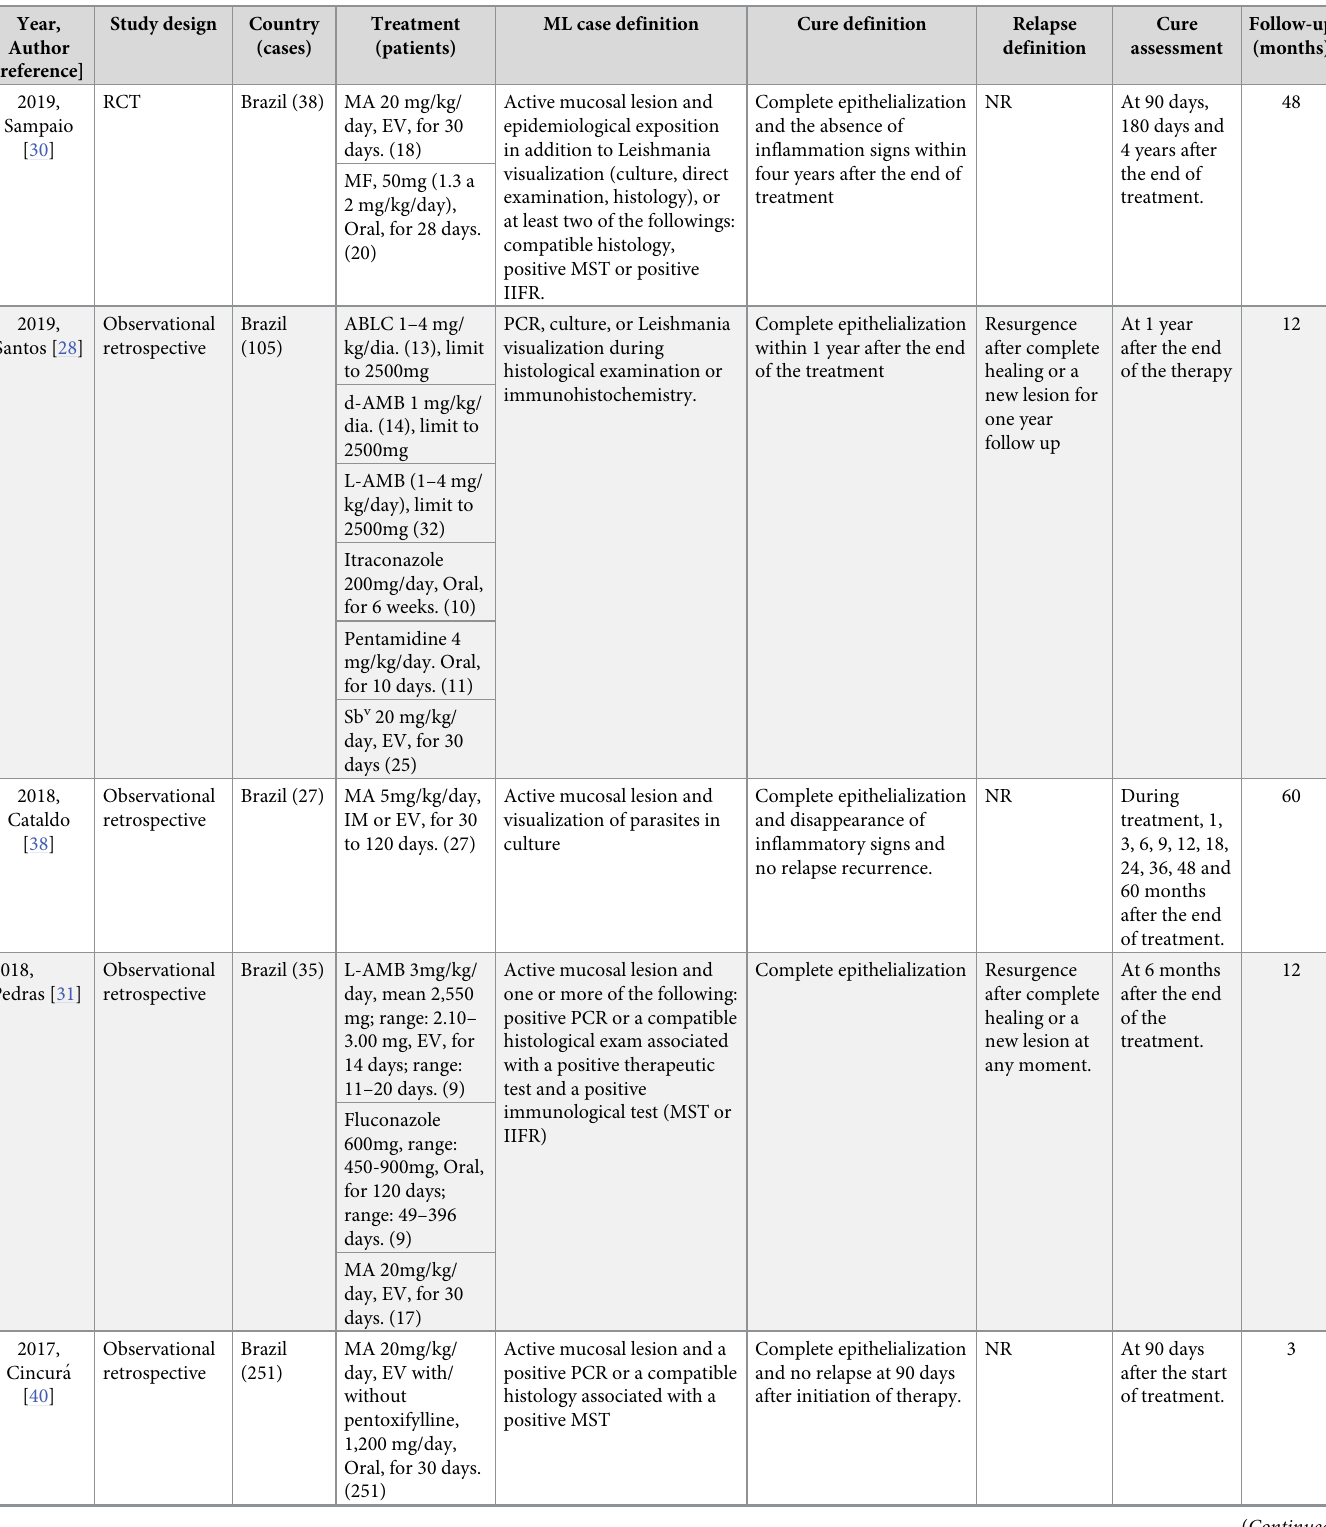
Table 1. Characteristics of the included